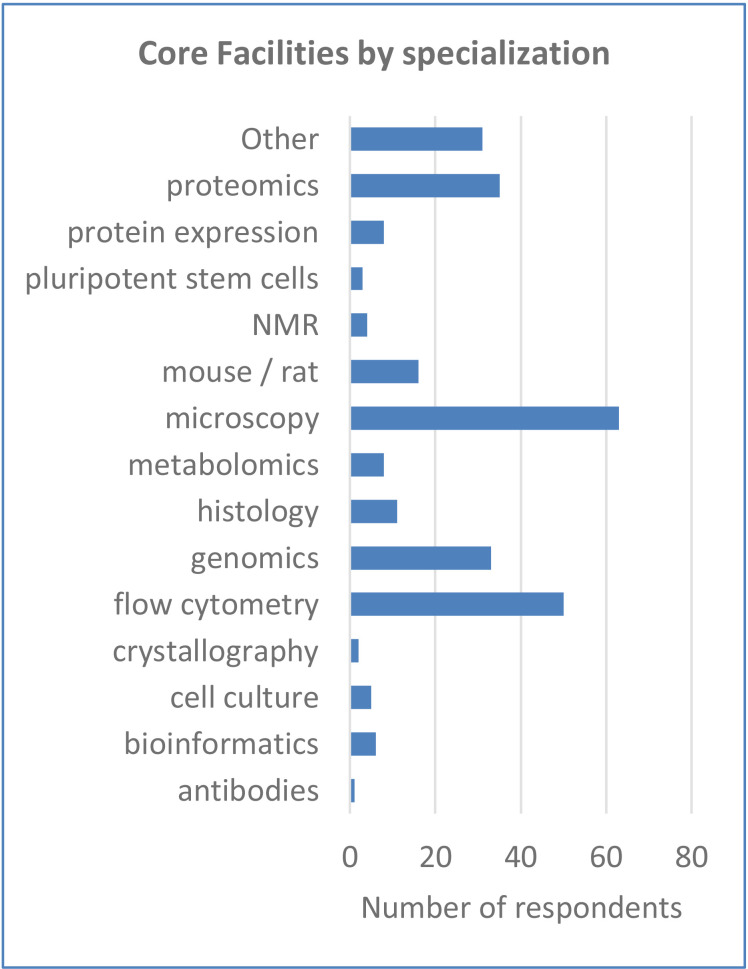
Distribution of surveyed core facilities according to their type of technology.NMR, nuclear magnetic resonance.